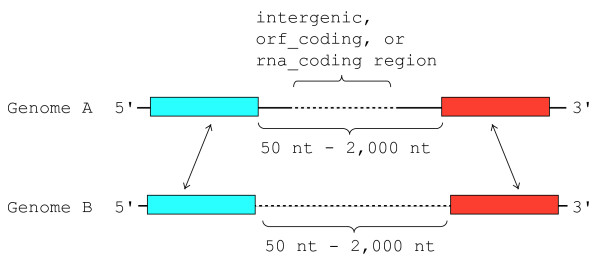
Definition of the target region to be scanned by Cofolga2. The conserved sequences are indicated by boxes, and matching sequences are represented by arrows. In this figure, Genome A conrresponds to S. cerevisiae, and Genome B corresponds to an other fungal genome. Dashed lines indicate the sequences belonging to the target region. A situation such that the arrows are crossing each other is not allowed. If a part of intergenic, orf_coding, or rna_coding region overlaps the conserved region, the overlapped part is excluded from the target region.